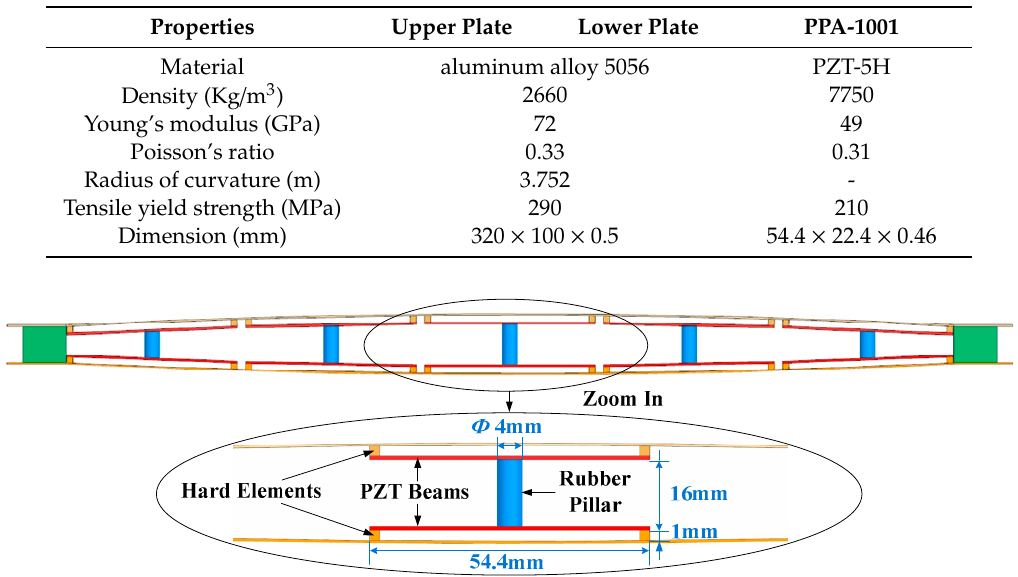
Table 1. Properties of the double-layer structure and piezoelectric beam substrate.